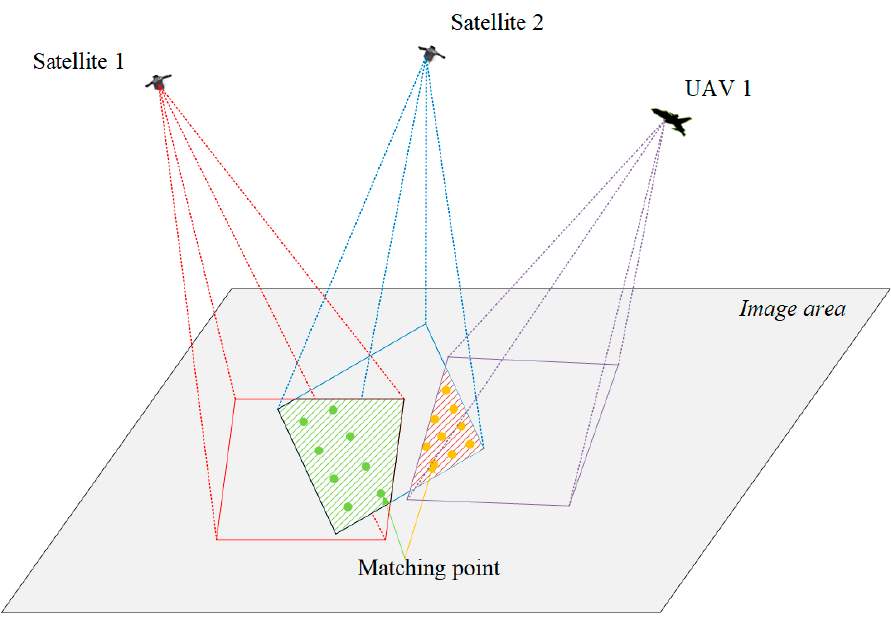
Figure 4. Selection of registration points for image coincidence